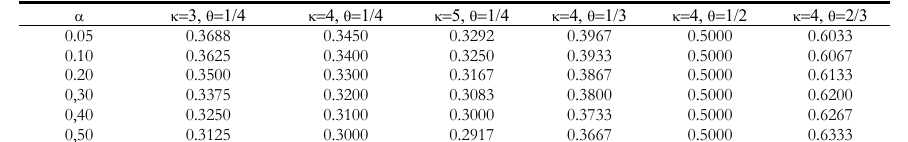
Expected value of MTSP as a function of α